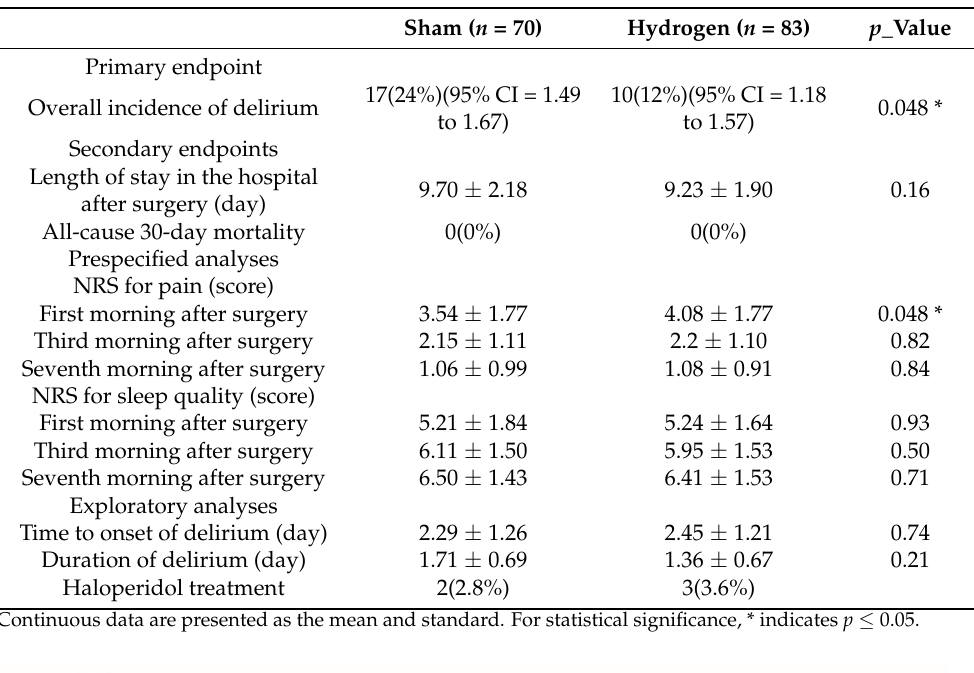
Table 3. Effectiveness outcomes.